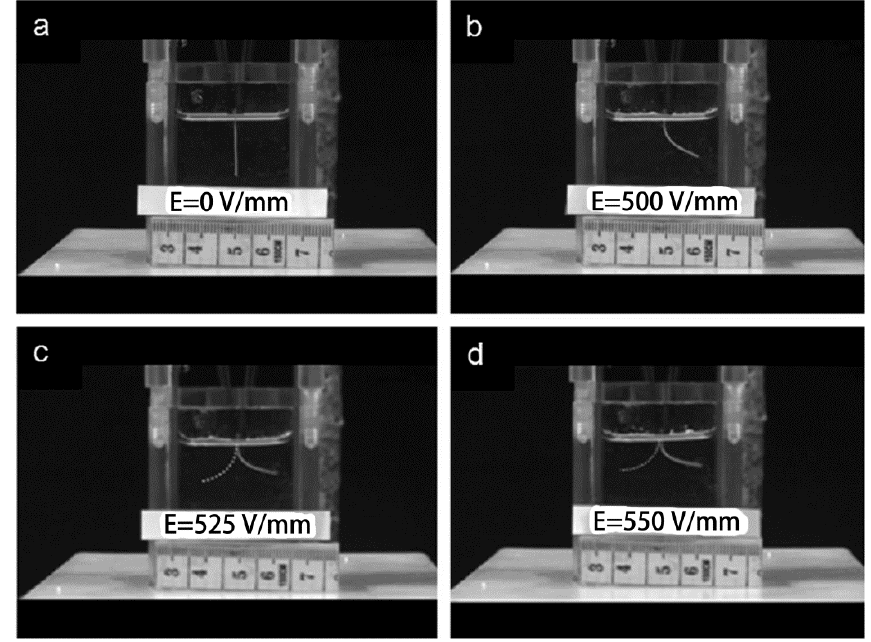
Figure 23. Deflection and back–forth swing images at 303 K under various applied voltages of the gel: ( a ) E = 0 V/mm; ( b ) E = 500 V/mm; ( c ) E = 525 V/mm; and ( d ) E = 550 V/mm. Note: The polarity of the electrode on the left and right hand sides are always GND and positive, respectively. Size of the gel sample: 16.5 mm of length, 1 mm of thickness, 3 mm of width, and 0.0309 g of weight. Reprinted with permission from [100]. Copyright 2012